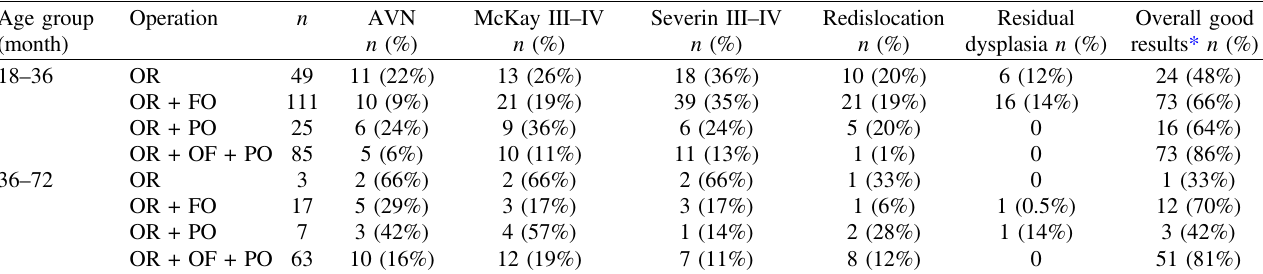
Table 4. Description of results according to 18 – 36 and 36 – 72 months age group and surgical techniques.